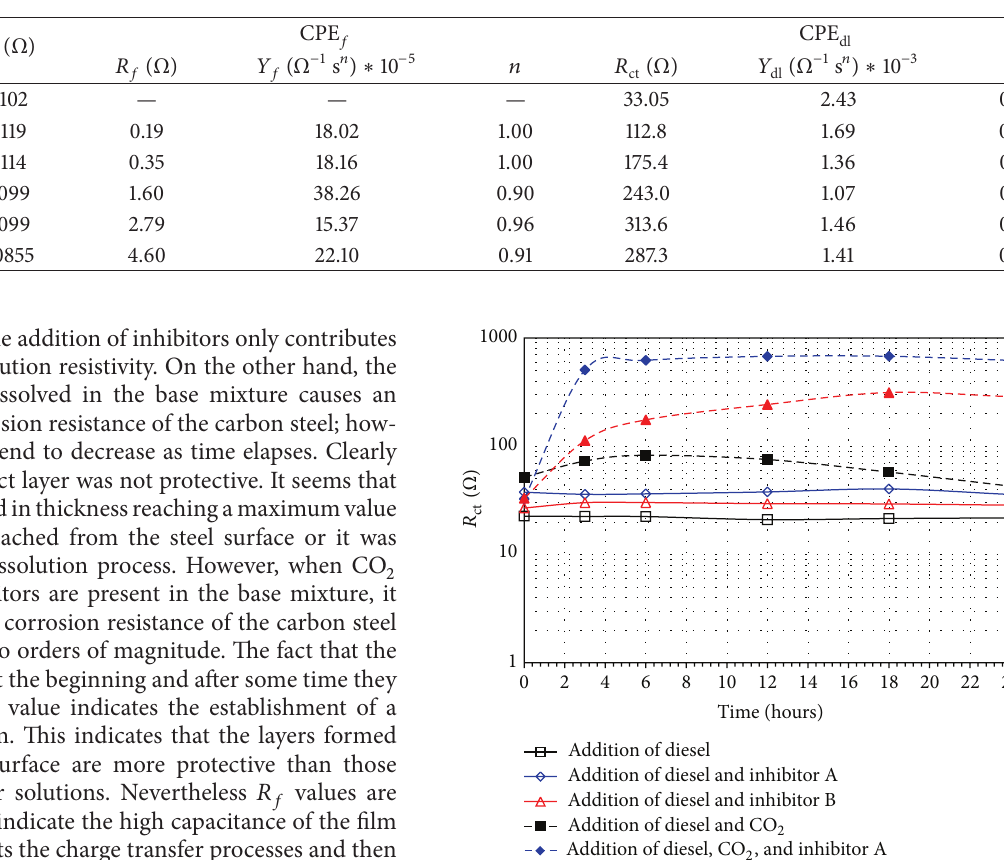
Table 6: Equivalent circuit parameters for effect of the addition of CO